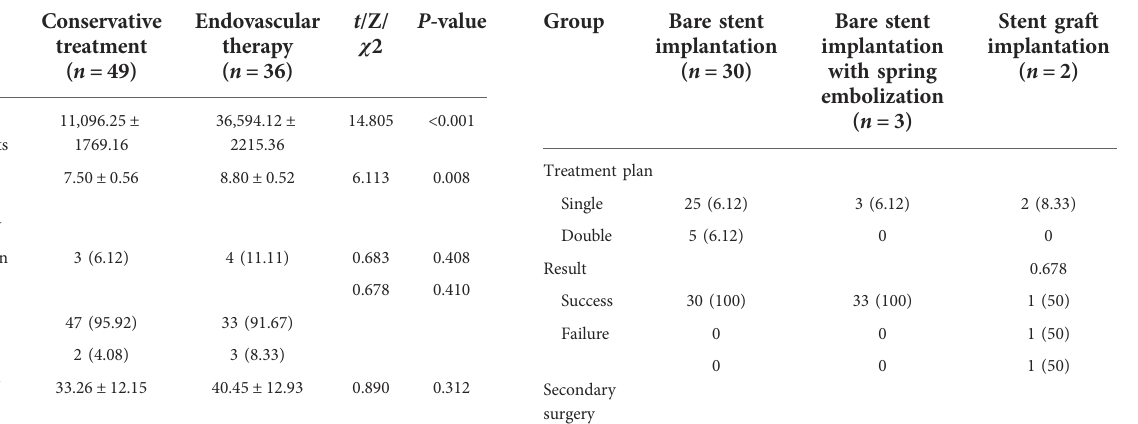
NRS, numerical rating scales.